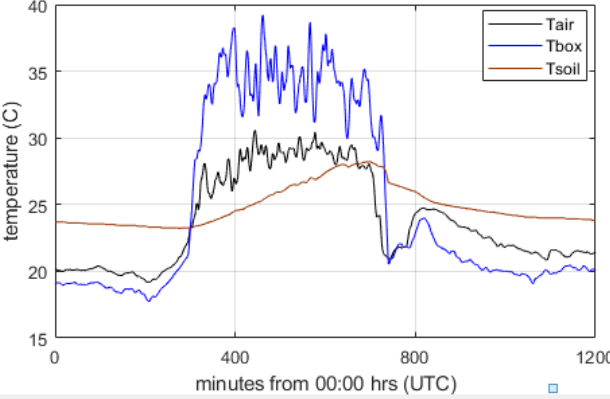
Figure 5 Variation of air temperature in free air, airtight box and